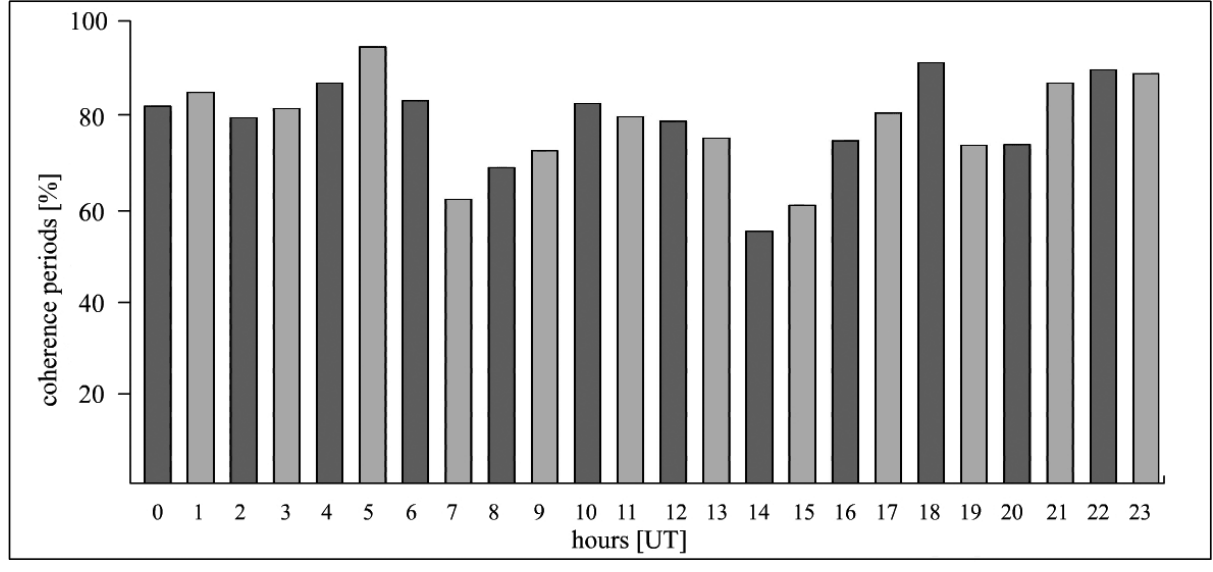
= 1 dBm and T = 5 km. dBm h'